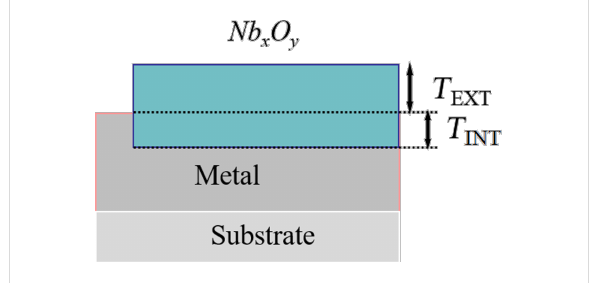
Figure 9: Scheme of the oxidized film grown on NbN. The total thick- ness of the oxide ( T EXT + T INT ) is higher than the initial thickness of NbN ( T INT ).